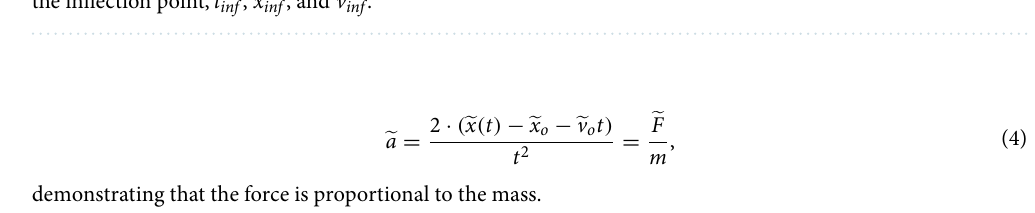
Table 3 provides the values for t (year), (cid:31) x inf and (cid:31) v inf at the inflection point for each social and environmental poll. The acceleration (cid:31) a is determined using Eq. (4) at the inflection points for each poll and plotted verses year (cid:31) F = m (cid:31) a is determined using a (unitless) abstraction of mass, or value normal- in Fig. 5. Likewise, the force term ized to the USA population in 1910, (cid:31) m 1910 = 1 .